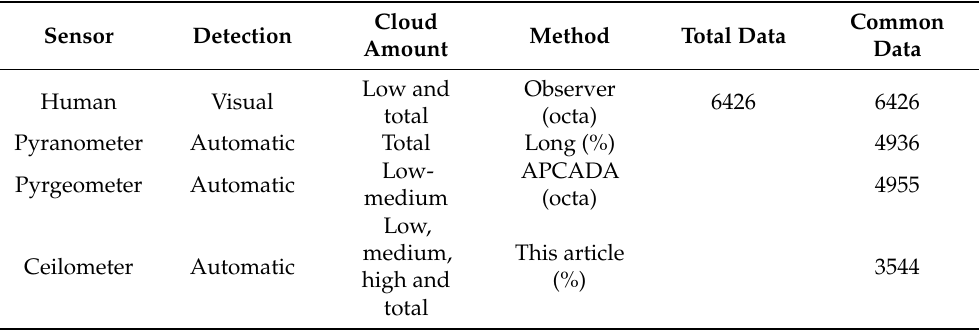
Table 2. Summary of the main characteristics of the methods used in this study to derive the cloud